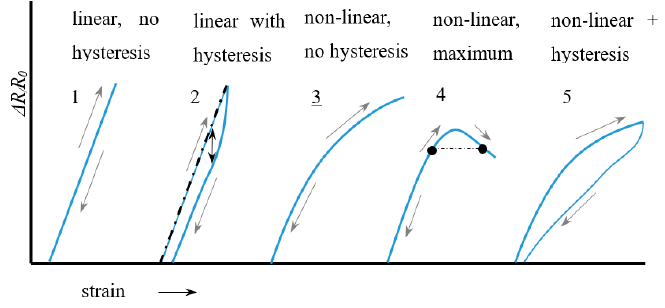
Figure 5. Non-linearity and hysteresis examples.